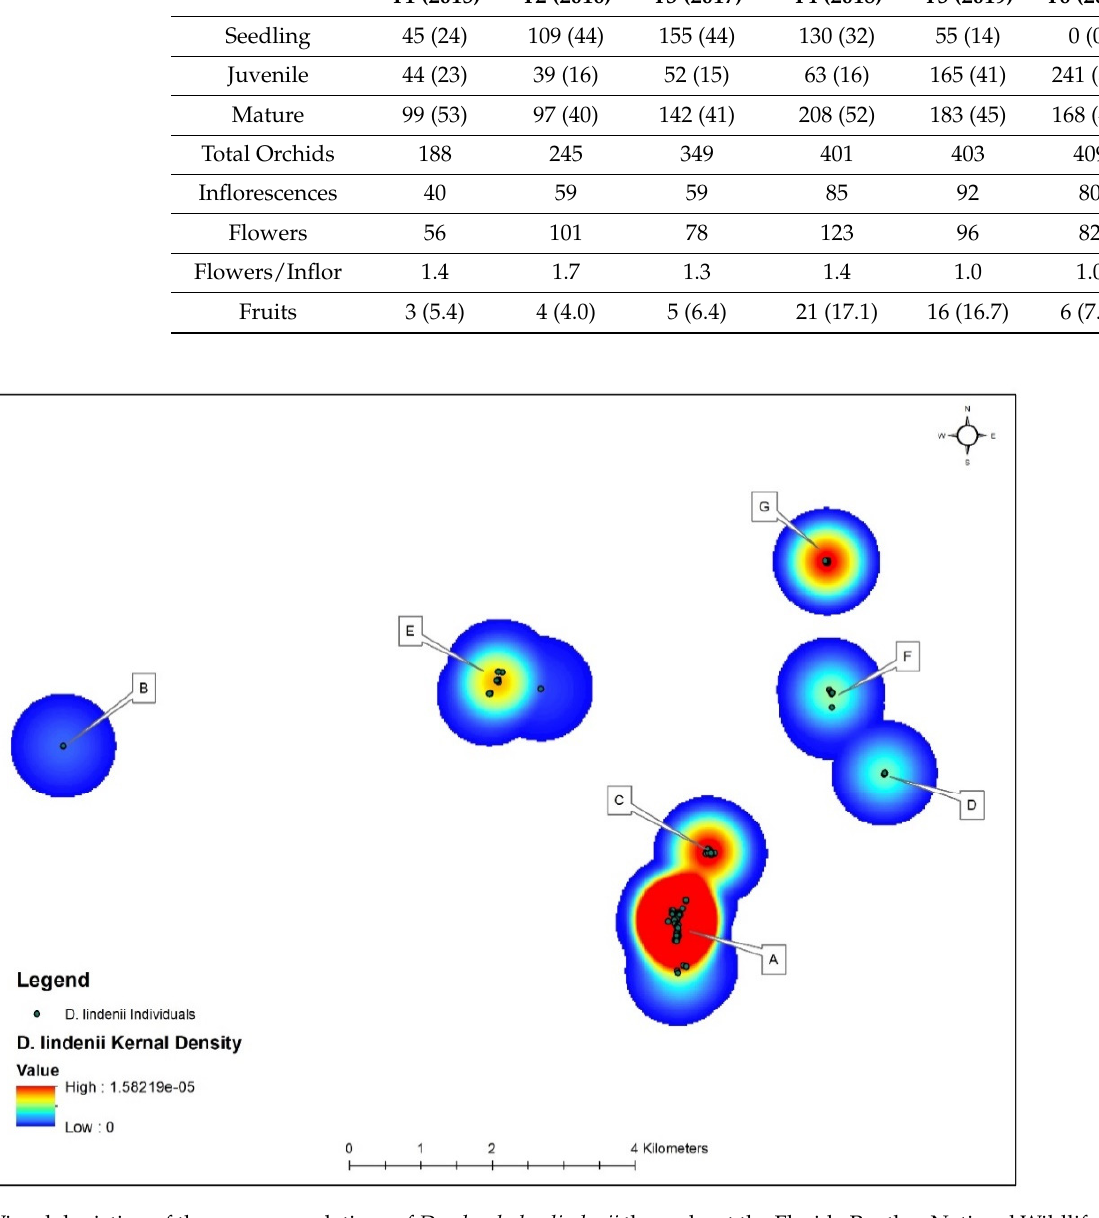
Figure 2. Visual depiction of the seven populations of Dendrophylax lindenii throughout the Florida Panther National Wildlife Refuge using kernel density analysis via ArcGIS. The colored circles depict orchid densities revealed as “hotspots”, with those in red indicating the highest densities. Note that Population A had the highest concentration of orchids and was the only site where spontaneous seedlings were recorded all 6 years.